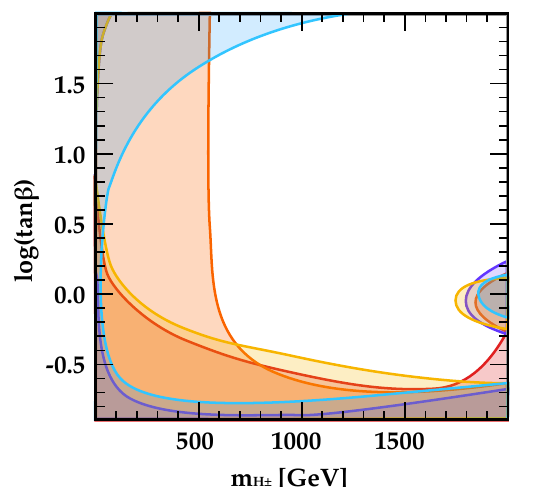
Figure 3. Flavour constraints in the plane of m H ± − log(tan β ) for type-II 2HDM. We plot the excluded regions at 2 σ with colored shadow: Yellow: BR( B s → µ + µ − ); Orange: BR( b → s γ ); Red: ∆ M Purple: R K and R ( ∗ ) ; Blue: Tree-level leptonic and semi-leptonic B and D decays: R D , R ( ∗ ) K τν, B → D µν, B → D ∗ µν and D s → τν, D s → µν, D → µν .